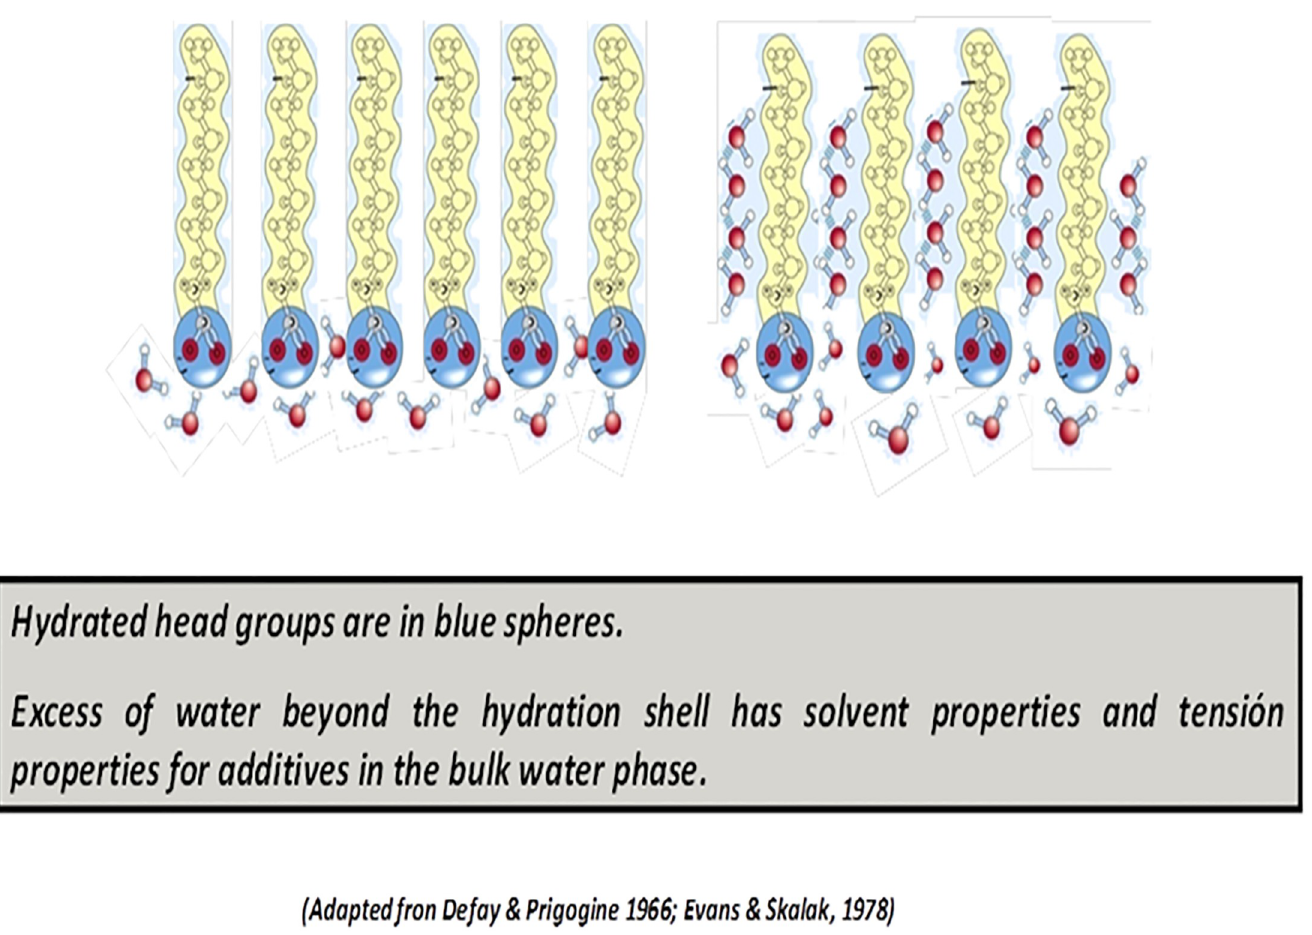
Fig 3. Schematic representation of lipid interphase showing lipids and its hydration shells.